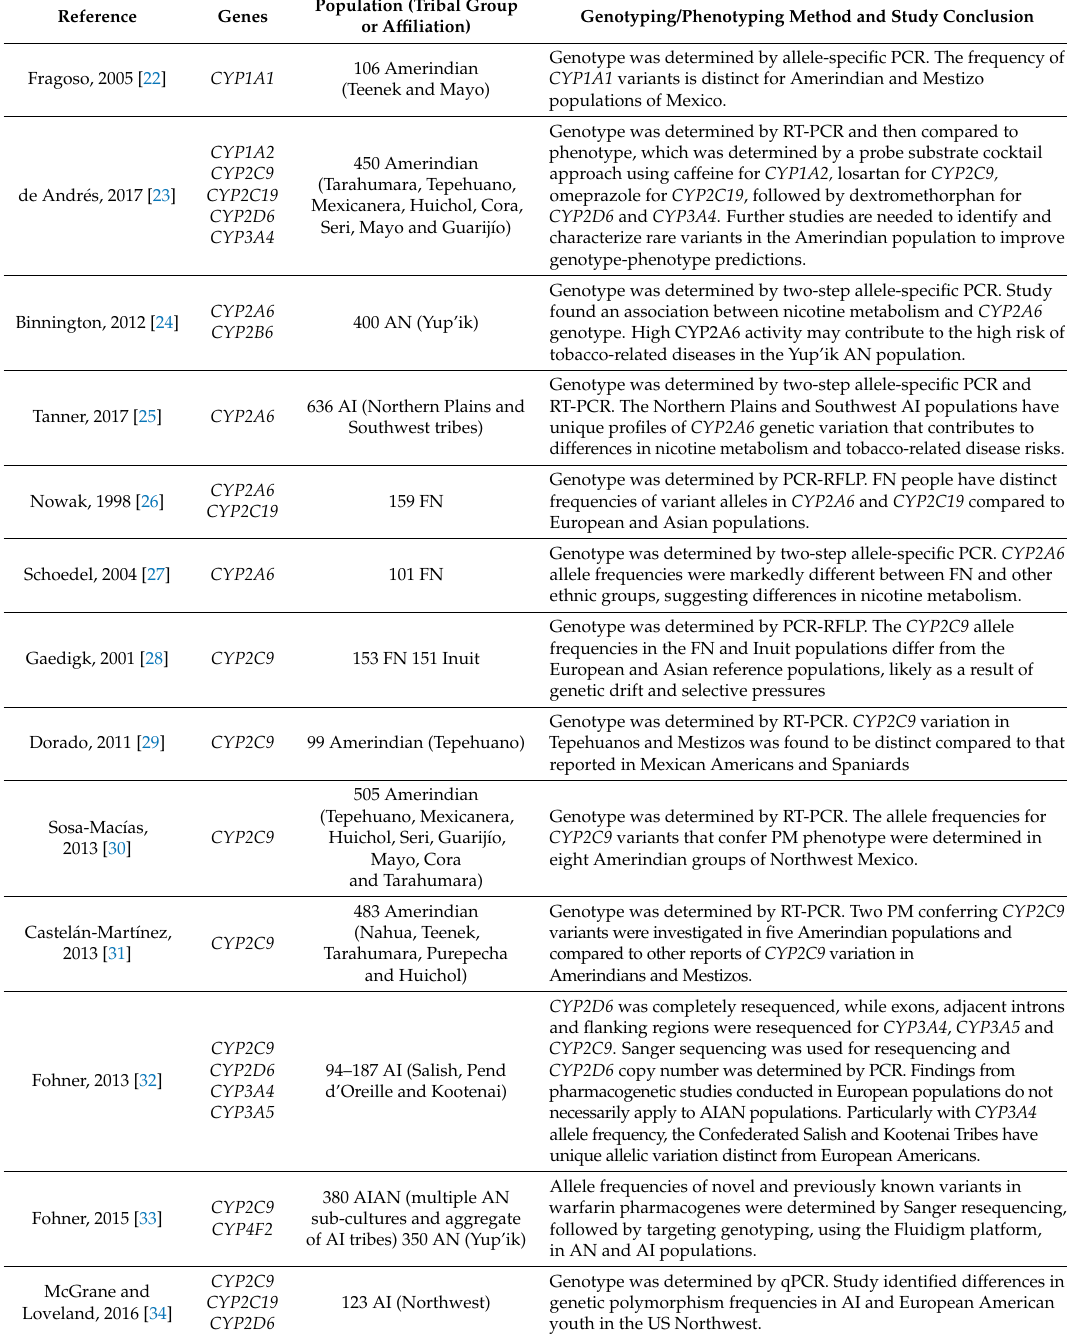
Table 1. Studies of P450 genetic polymorphisms in Indigenous North American